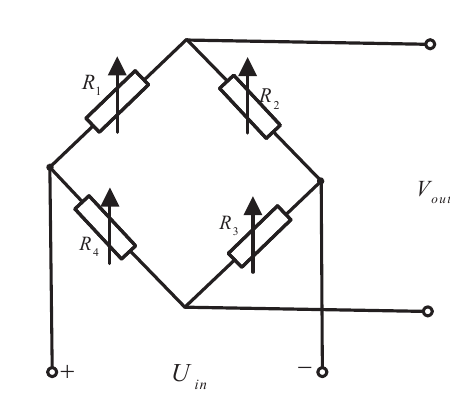
Figure 12. The silicon cup full-bridge circuit with four force-sensitive components.